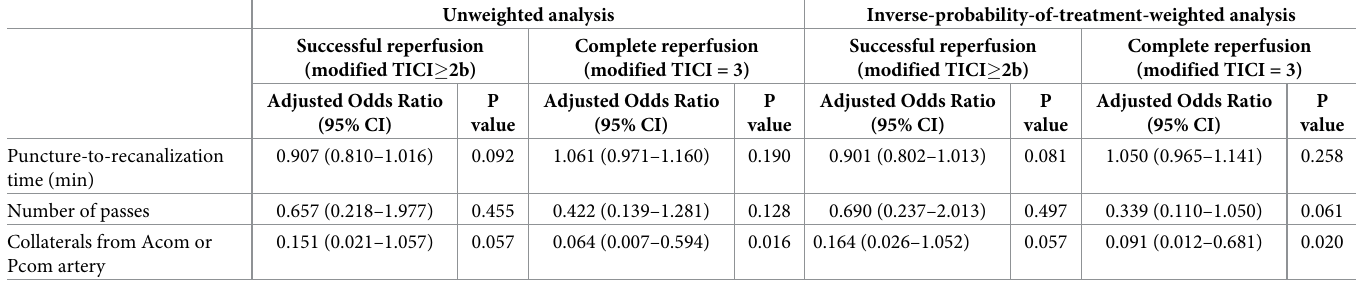
Table 4. Multivariable logistic regression analysis with dependent variables for successful reperfusion and complete reperfusion in the proximal DAC group (n =